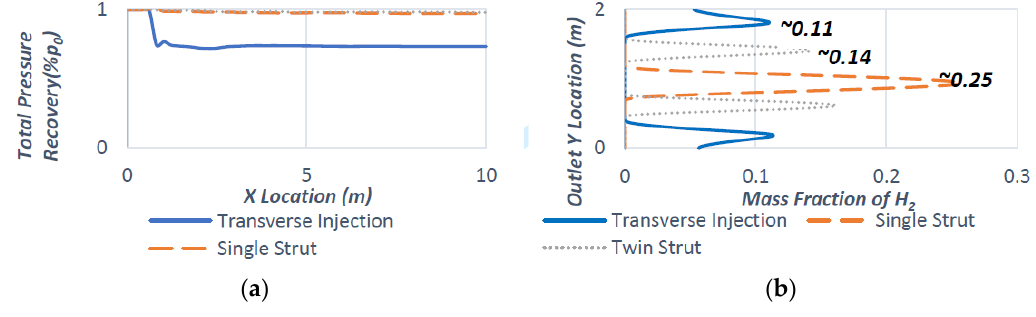
Figure 27. ( a ) Combustor total pressure loss; ( b ) Mass fraction of H 2 remaining at outlet.